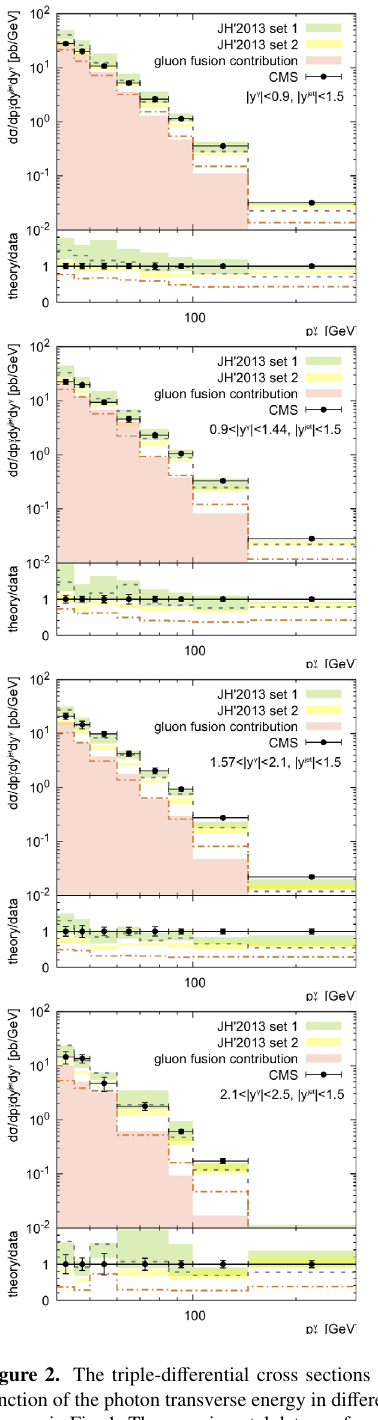
Figure 2. The triple-di ff erential cross sections of associated γ + jet production at √ s = 7 TeV as function of the photon transverse energy in di ff erent regions of rapidities. Notation of histograms is the same as in Fig. 1. The experimental data are from